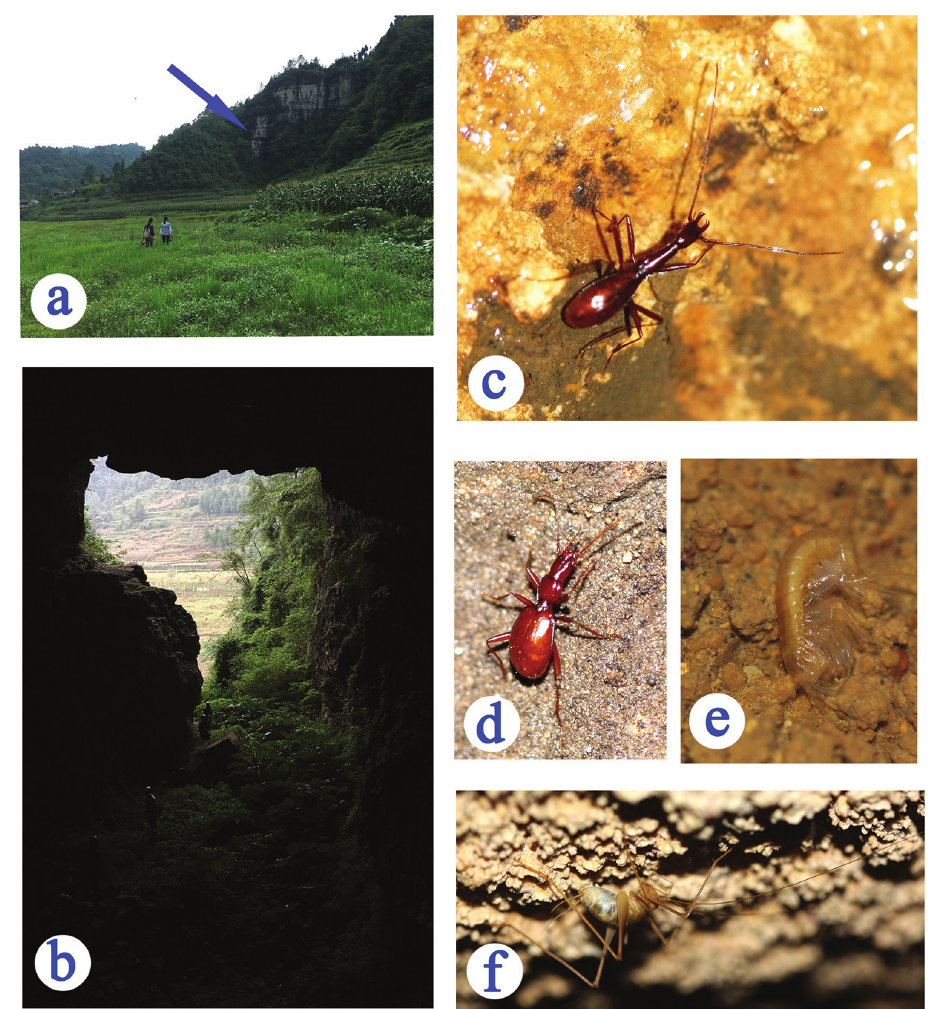
Figure 6. Cave Mahuang Dong, the type locality of Shuangheaphaenops elegans gen. n., sp. n., and some sympatric cave animals a opening, showed by arrowhead b entrance c Shuangheaphaenops elegans d a Qianotrechus tenuicollis Uéno, 1998 e amphipod f cave